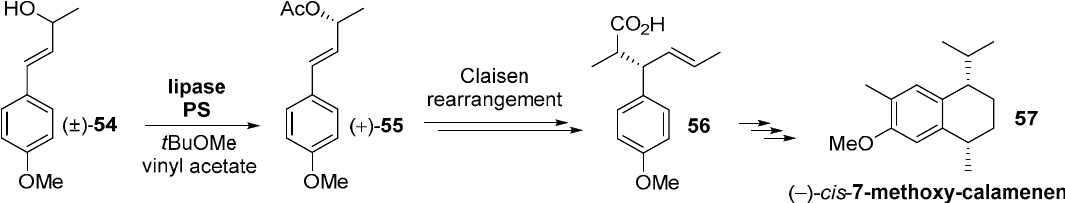
Figure 11. Lipase-mediated resolution of ( E )-4-(4-methoxyphenyl)but-3-en-2-ol ( 54 ) and use of the chiral building block 55 for the enantioselective synthesis of the sesquiterpene cis -7-methoxy-calamelene ( 57 ).